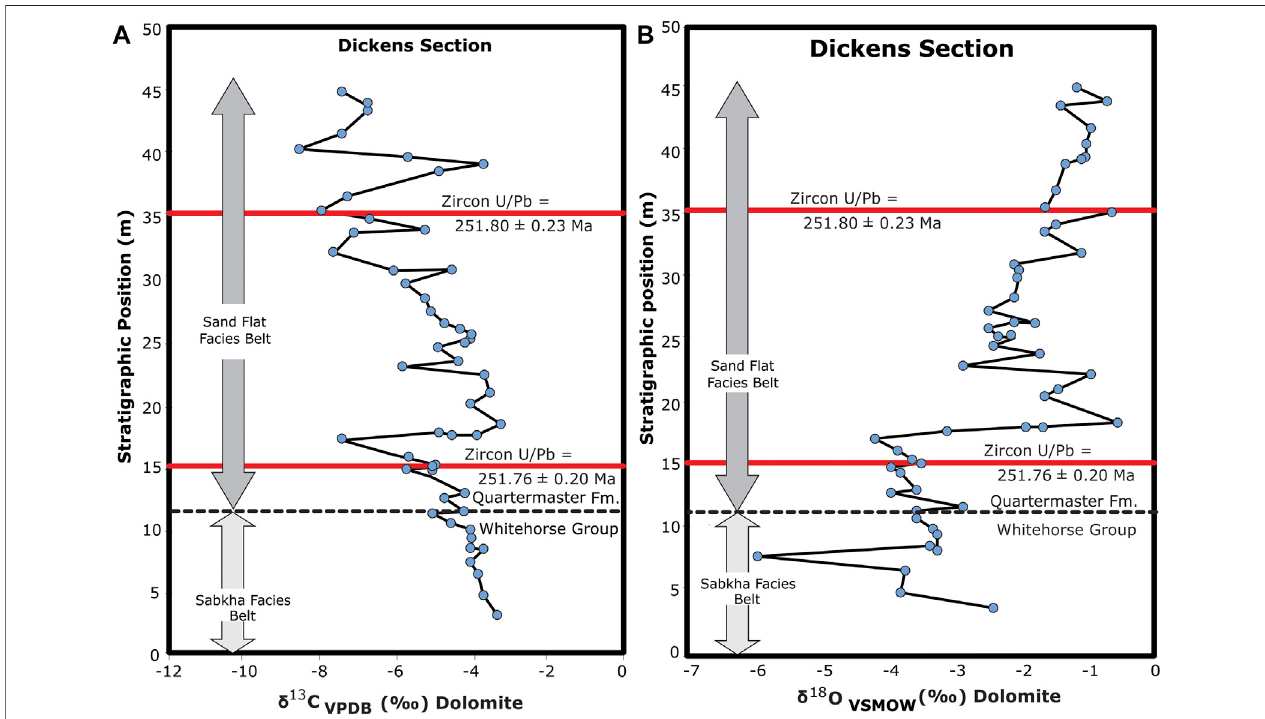
FIGURE 14 | (A) Chemostratigraphic chart of the stratigraphic position vs. dolomite δ 13 C value of dolomicrite cements from the stratigraphic section near Dickens (B) Chemostratigraphicchartofthestratigraphicpositionvs.dolomite δ 18 OvalueofdolomicritecementsfromthestratigraphicsectionnearDickens.Redlinesandblack dashed line in both graphs represent the position of volcanic ashes and the stratigraphic boundary between the lower Whitehorse Group strata and the upper Quartermaster Formation strata, respectively. See text for detailed discussion.